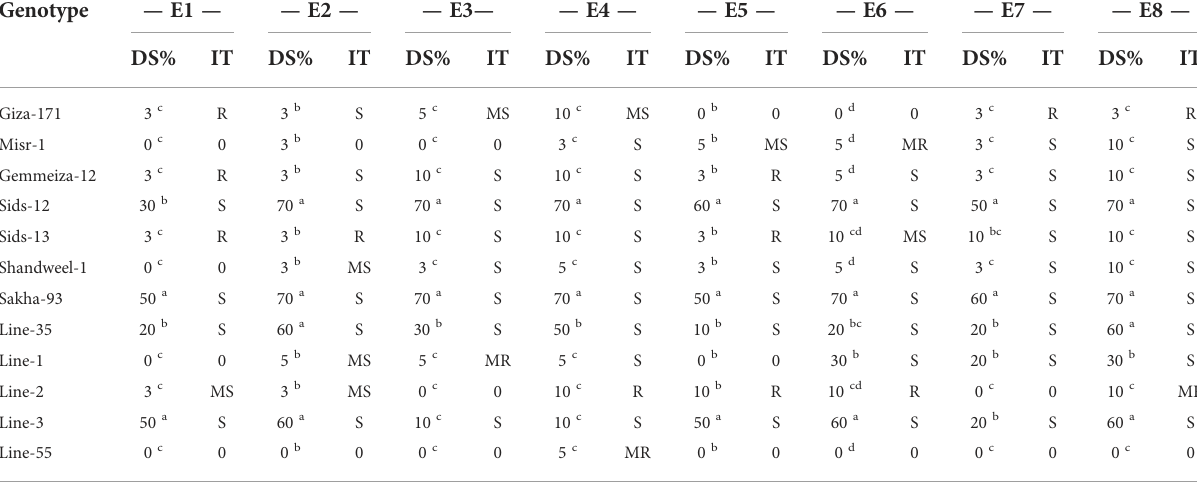
E1-E8 are the evaluated environments as presented in Table 1. DS%: rust severity as a percentage of leaf area covered by yellow rust pustules following the modi fi ed Cobb ’ s scale of 0-100%. IT, infection type; 0, No infection detected, R, Resistant small pustules surrounded by necrosis, MR, Moderately resistant; small to medium pustules surrounded by green island, MS, Moderately susceptible; medium-sized pustuleswithout necrosisorchlorosis,S,susceptible largesizedpustules withoutchlorosisornecrosis. Thesamelettersunderthesameenvironment are not signi fi cantly different by the least signi fi cant difference at p ≤ 0.05.